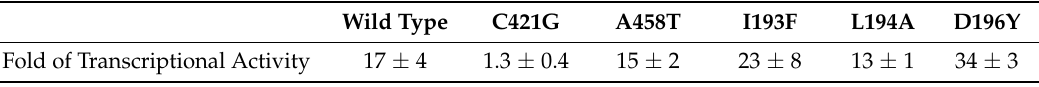
Table 2. Transcriptional activities of hGR wild type and